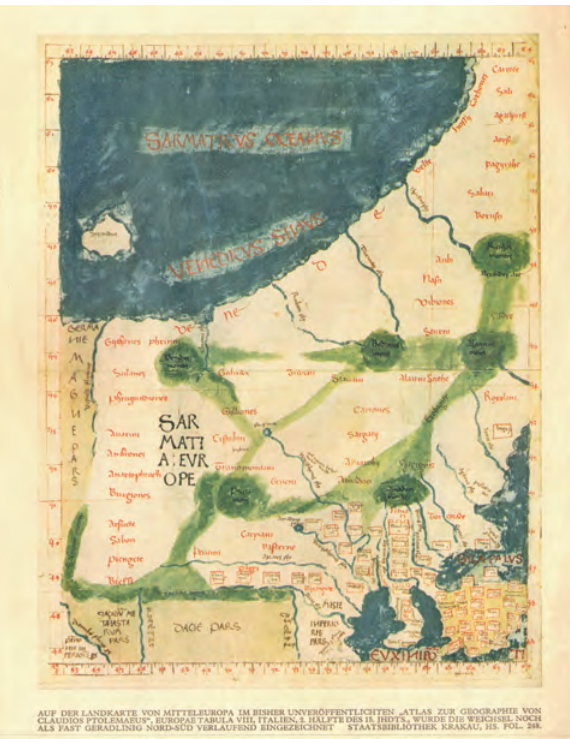
Fig. 1. Map of Europae Tabula VIII iš „Atlas zur geographie von Claudios Ptolomeus“, Krokuvos valstybinė biblioteka, atlasas Fol. 248